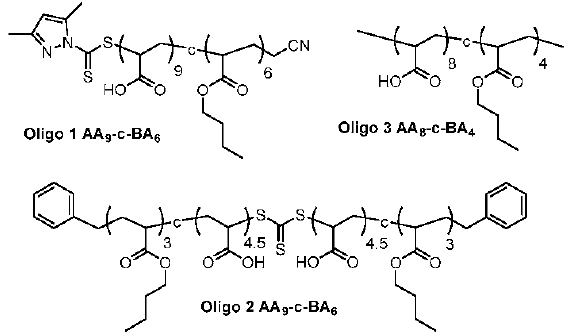
Figure 3. Chemical structures of Oligo 1 [RAFT1481 (BA 6 - co -AA 9 )], Oligo 2 [RAFT1361 (BA 6 - co -AA 9 )] and Oligo 3 (BA 4 - co -AA 8 ).